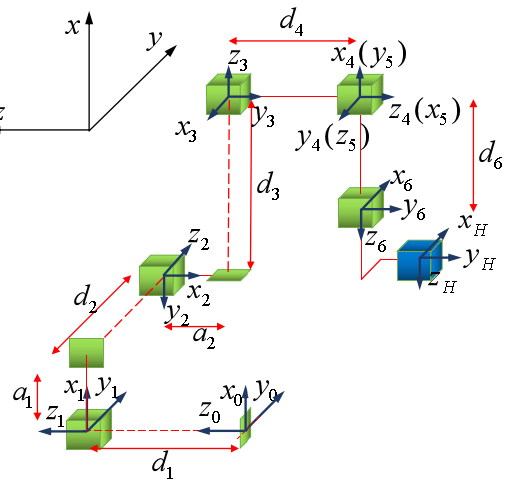
Figure 6. Kinematic parameters and coordinate settings of a six DoF micromotion stage. The transformation matrix of the reference coordinate system between adjacent joints can be written as ii − 1 T = A i according to the Denavit-Hartenberg (D-H) [14] approach to robot kinematic modeling, i.e.,